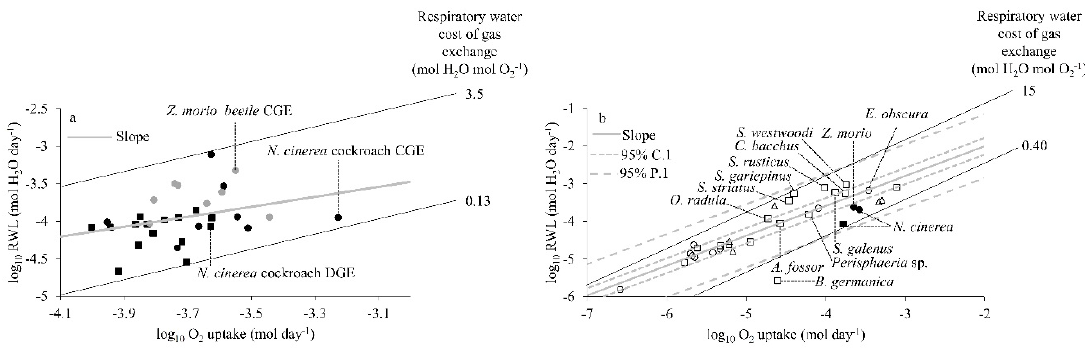
Figure 4. The relationships of log 10 RWL and log 10 (cid:1848)(cid:4662) (cid:3016) for cockroach and beetle individuals from ( a ) our study, and ( b ) of 30 insect species showing different gas exchange patterns (CGE: Open circles; DGE: Open squares; cyclic: Open triangles; cockroach and beetle species are labelled) from Woods and Smith’s [17] model of respiratory water cost of gas exchange (see Supplementary Table S5). Three data points (filled symbols) for average respiratory water cost of gas exchange of individuals from our study were superimposed to this multispecies relationship for comparison. Higher and lower respiratory water costs of gas exchange are shown on both panels based on data spread.